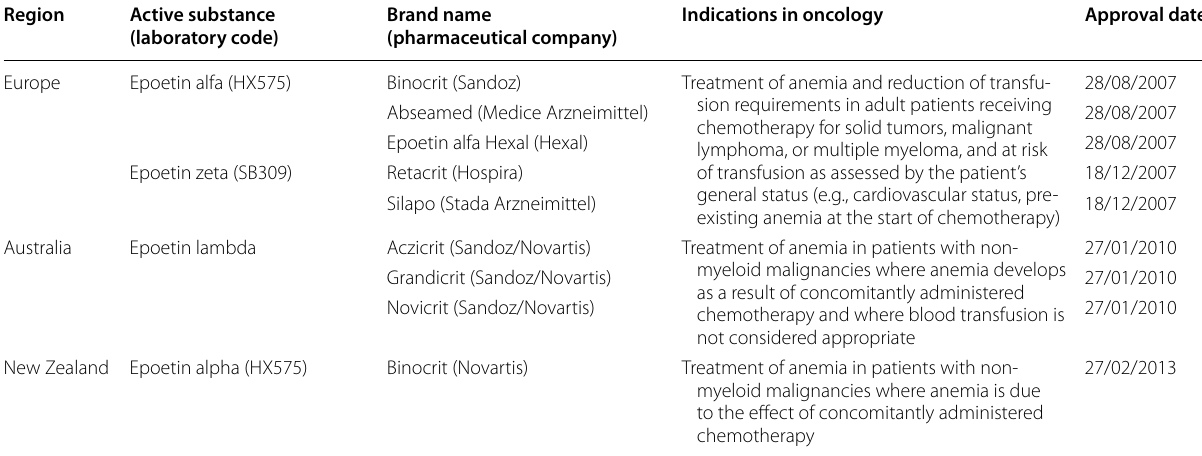
Table 4 List of currently approved erythropoietin biosimilars